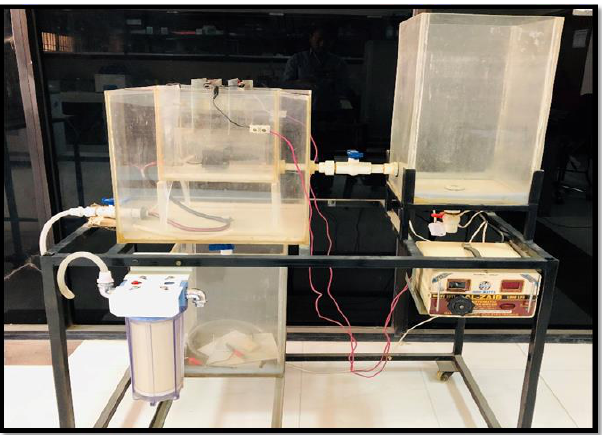
Fig. 2. Setup for electrocoagulation treatment